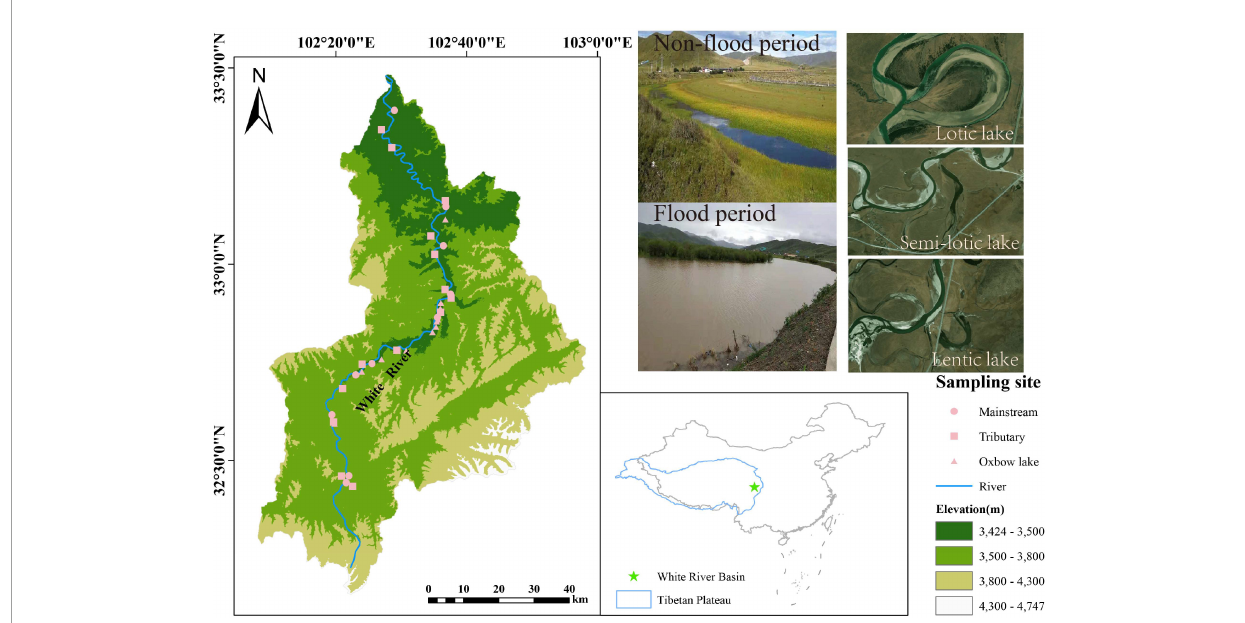
FIGURE1 Spatial distribution of sampling points in the White River Basin during the non-flood and flood